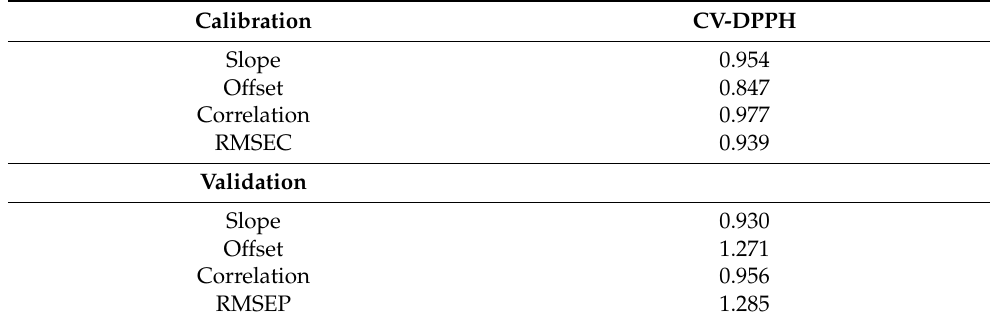
Table 7. PLS results of CV-DPPH regression models in calibration and